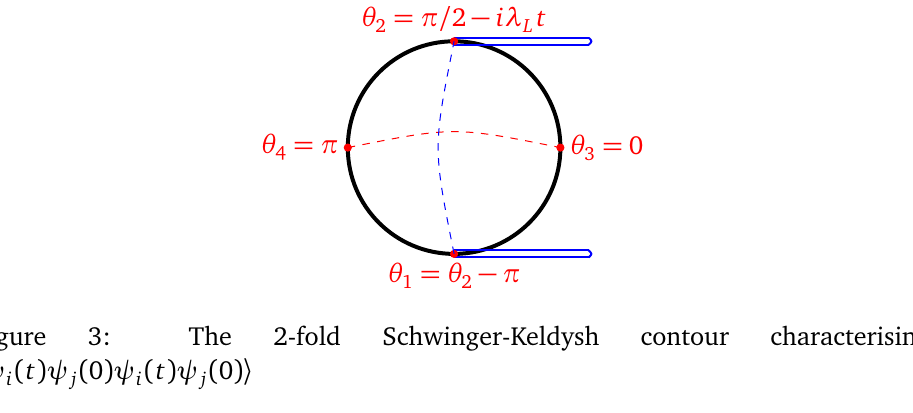
Figure 3: The 2-fold Schwinger-Keldysh contour characterising 〈 ψ ( t ) ψ ( 0 ) ψ ( t ) ψ ( 0 ) i j i j